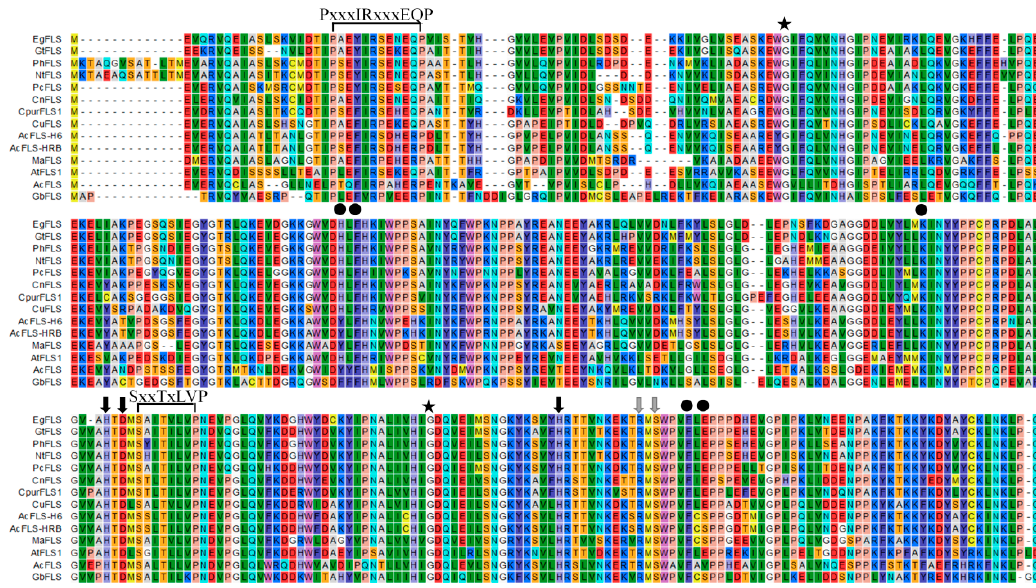
Figure 1. Multiple alignment of the predicted amino acid sequence of MaFLS with that of other flavonol synthase (FLS) proteins. MaFLS is compared with FLS sequences from Eustoma grandiflorum (EgFLS), Gentiana triflora (GtFLS), Petunia hybrida (PhFLS), Nicotiana tabacum (NtFLS), Petroselinum crispum (PcFLS), Camellia nitidissima (CnFLS), Cyclamen purpurascens (CpurFLS1), Citrus unshiu (CuFLS), Allium cepa (AcFLS-H6 and AcFLS-HRB), Arabidopsis thaliana (AtFLS1), Acacia confusa (AcFLS), and Ginkgo biloba (GbFLS). The alignment was generated using CLC sequence viewer 8.0. The FLS-specific motifs “PxxxIRxxxEQP” and “SxxTxLVP” are indicated. Black arrows indicate the ferrous iron-binding residues (His216, Asp218, and His272). Gray arrows represent the 2-oxoglutarate binding residues (Arg282 and Ser284). Black dots show the putative DHQ-binding residues (Tyr127, Phe129, Lys197, Phe288, and Ser290). Asterisks indicate the residues responsible for the proper folding of the FLS polypeptide (Gly65 and Gly256).